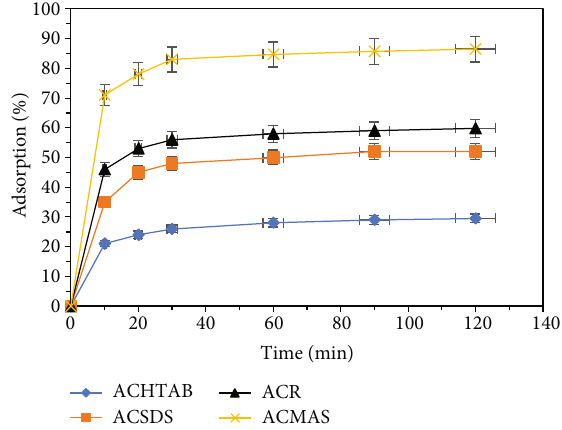
Figure 2: CV sorption onto di ff erent AC ’ s ( dye conc : = 50 mg/L , pH = 6 : 0 , T = 303K , and adsorbentdose = 0 : 15 g/L ).